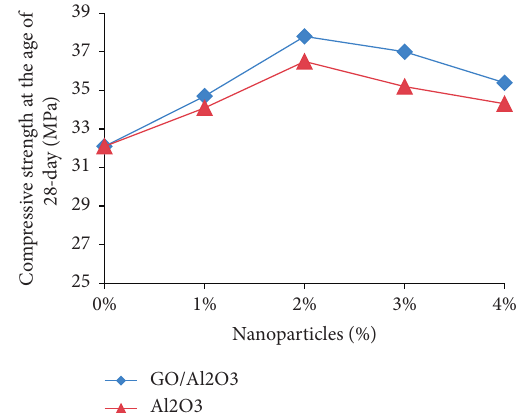
Figure 11: : Compressive strength of the concrete samples con- taining nanoparticles.